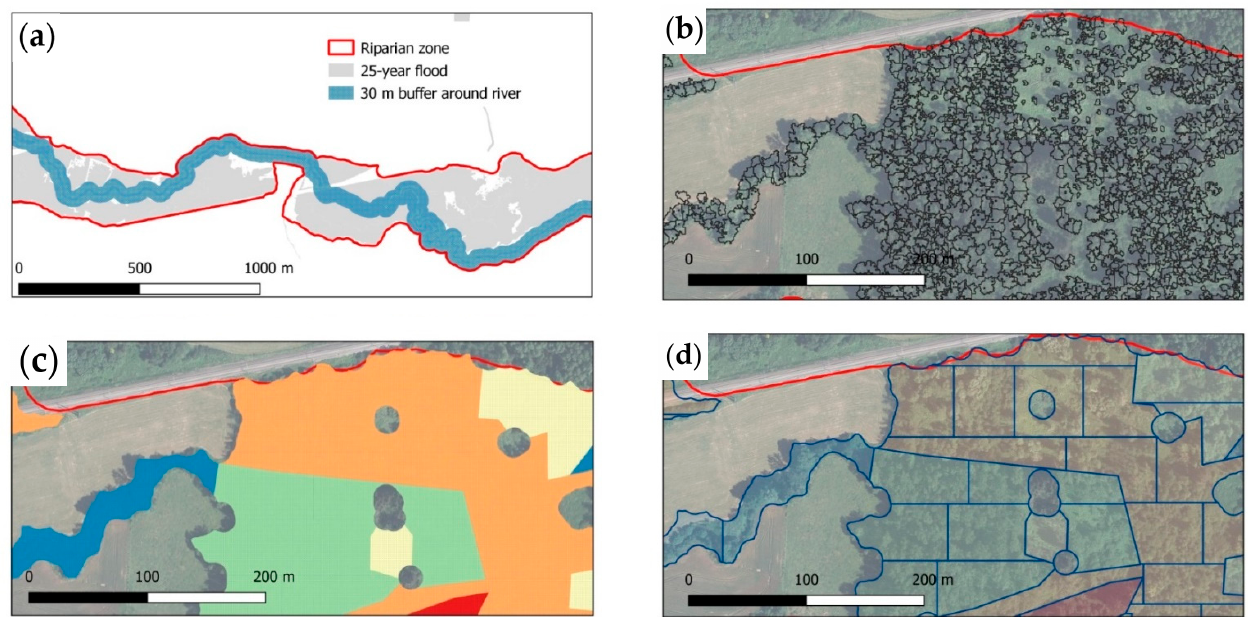
Figure 4. ( a ) Delineation of riparian zone as the sum of two envelopes: area flooded every 25 year and 30-m buffer on either side of the river. ( b ) Segmentation of tree crowns within the riparian zone. ( c ) Morphological filtering on the segmented tree crowns and first division into zones of similar age (each color corresponds to a different age). ( d ) Division of this envelope into vegetation units (VUs) of approximately 0.3 ha.